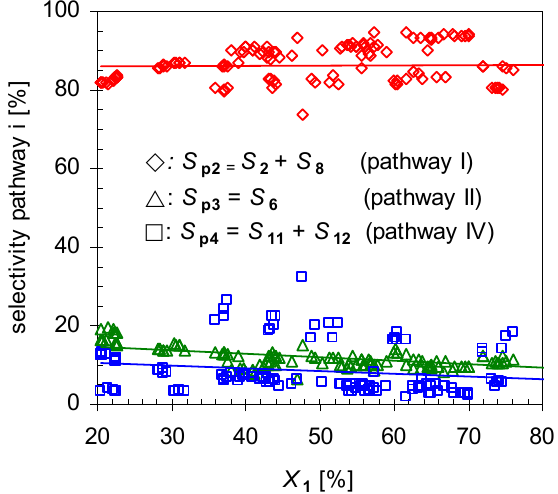
Figure 4. Dependency of overall linalool selectivity (S , triangles) and hydrocarbons ( S ( S p3 conversion of pinan-2-ol ( X 0.4–1.2 L min − 1 , τ : 0.6–0.8